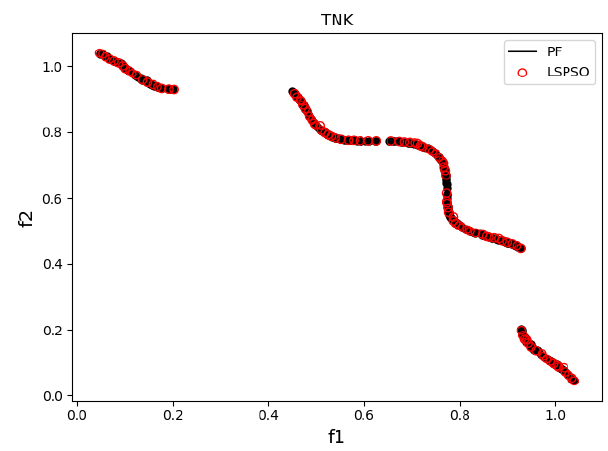
Figure 5. Pareto optimal solutions obtained by LSPSO for TNK.